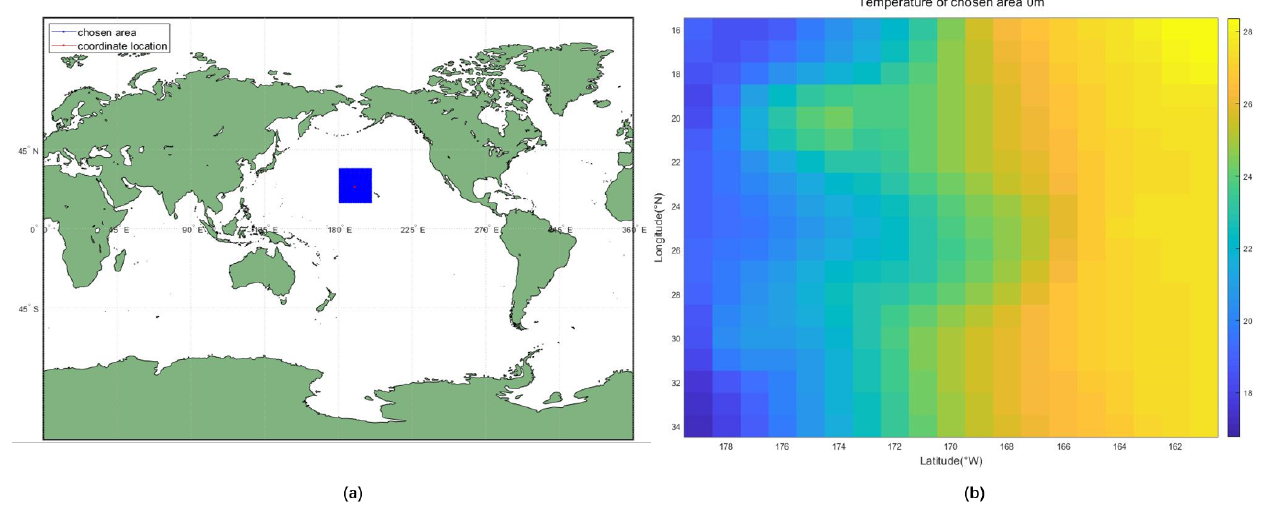
Figure 1. ( a ) The location of chosen area; ( b ) the average sea surface temperature in January 2004.